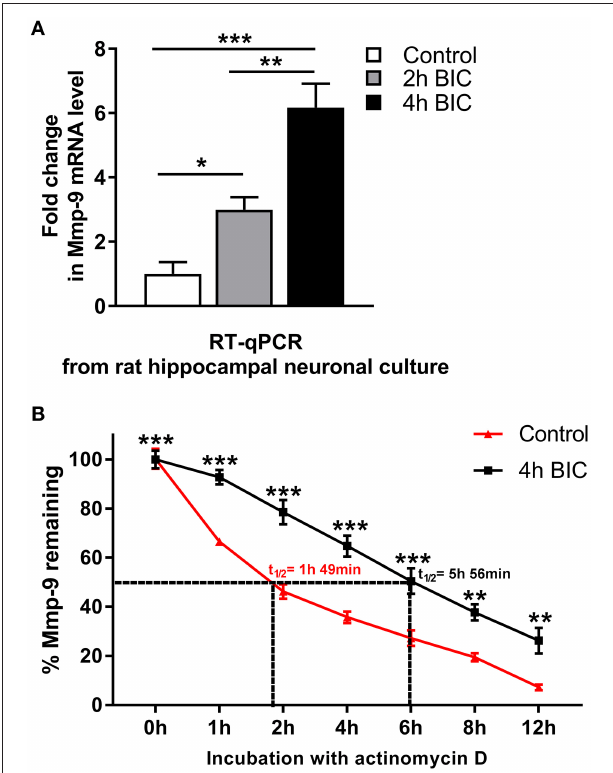
FIGURE 5 | Bicuculline-evoked neuronal activation triggers upregulation and stabilization of Mmp-9 mRNA in hippocampal neurons. (A) Mmp-9 mRNA accumulates in primary rat hippocampal neuronal cultures after neuronal activation. On Day 7 in vitro , neuronal cultures were treated with bicuculline (50 µ M). For each analysis, equal amounts of RNA samples isolated from the unstimulated (control) and activated (2 and 4h after bicuculline) cultures were used. Mmp-9 expression was normalized against 18S rRNA expression. One-way ANOVA was followed by Tukey’s multiple comparisons test. Values are mean ± SEM (* p < 0.05; ** p < 0.01; *** p < 0.001; n = 6). (B) Bicuculline treatment strongly extends the Mmp-9 mRNA half-life in primary hippocampal neurons. On Day 7 in vitro , actinomycin D (5 µ g/mL) was added to the medium of the unstimulated (control) and activated (4h after bicuculline) hippocampal neuronal cultures for 30min. Then, RNA was isolated from the cultures at 0, 1, 2, 4, 6, 8, and 12h after administration of actinomycin D, and Mmp-9 mRNA expression was evaluated by qRT-PCR. Mmp-9 mRNA expression was normalized against 18S rRNA expression. Results are presented as a percentage of the remaining Mmp-9 mRNA transcripts (the amount of Mmp-9 mRNA at Time 0 is assumed to be 100%). Two-way ANOVA followed by Bonferroni’s multiple comparisons test. Values are mean ± SEM (** p < 0.01; *** p < 0.001; n = 4).